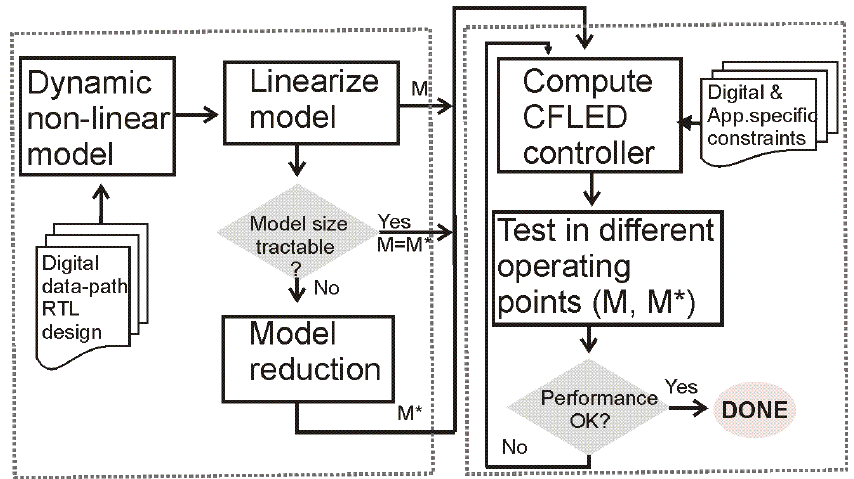
Figure 2. CFLED design